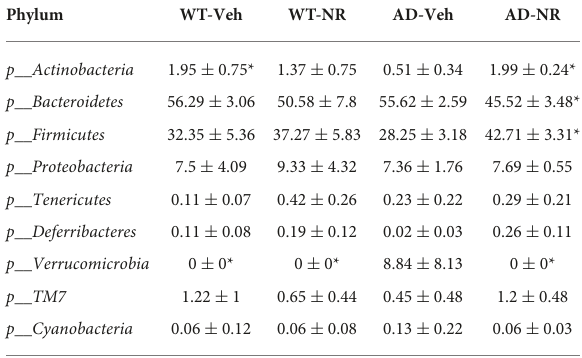
TABLE 3 The relative abundance (%) analysis at the genus